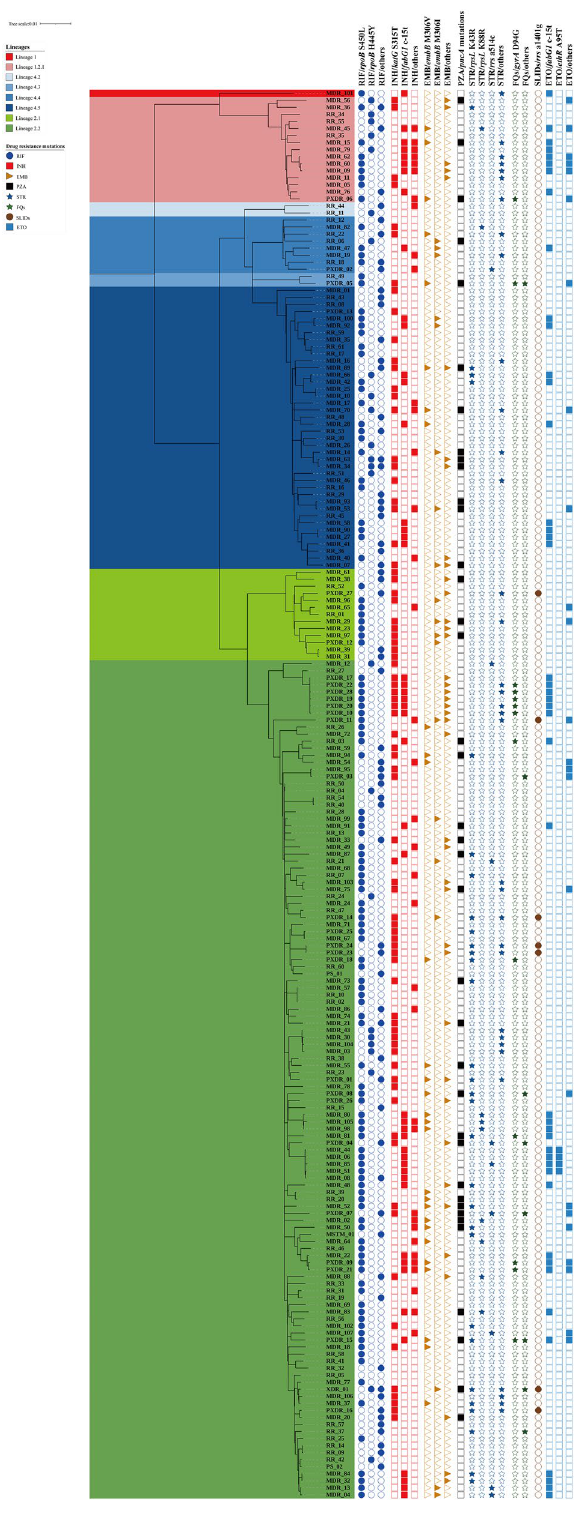
Figure 3. Maximum likelihood phylogenetic tree of the 200 DR-TB isolates from Taiwan. The tree was constructed based on 12,015 genome-wide SNPs. Lineages are represented by different colored blocks. Mutations are represented by filled (presence of mutation) or empty (absence of mutation) symbols. The figure was generated using iTOL v6 (https:// itol. embl. de). The scale bar indicates the genetic distance proportional to the total number of SNPs. Abbreviations: RIF, rifampicin; INH, isoniazid; EMB, ethambutol; PZA, pyrazinamide; STR, streptomycin; FQs, fluoroquinolones; SLIDs, second-line injectable drugs; ETO, ethionamide; MDR, multidrug resistant; RR, rifampicin resistant; PXDR, pre-extensively drug resistant; XDR, extensively drug resistant; MSTM, mono-streptomycin resistant; PS,